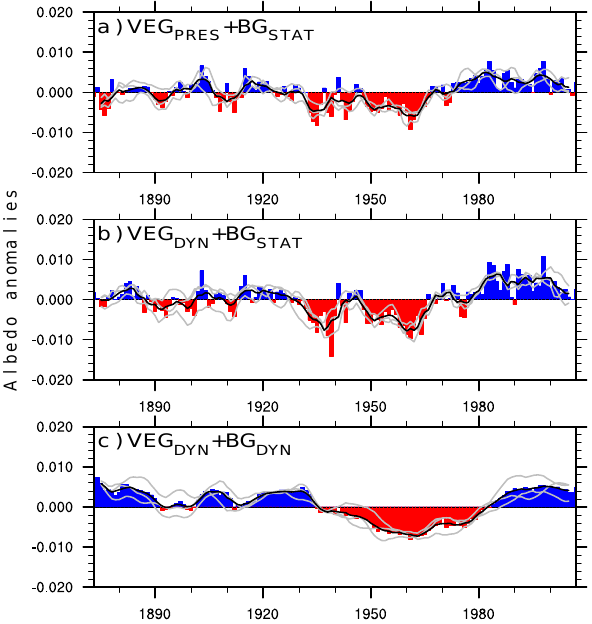
Fig. 8. Albedo anomalies with regard to mean albedo for the years 1901–2006 in the Sahel for the (a) static (VEG PRES + BG STAT ) simulations, (b) dynamic vegetation (VEG DYN + BG STAT ) simula- tions, and (c) dynamic vegetation and albedo (VEG DYN + BG DYN ) simulations. Bars show annual values of the ensemble mean. Lines show 5yr running averages for the individual ensemble members (grey) and the ensemble mean